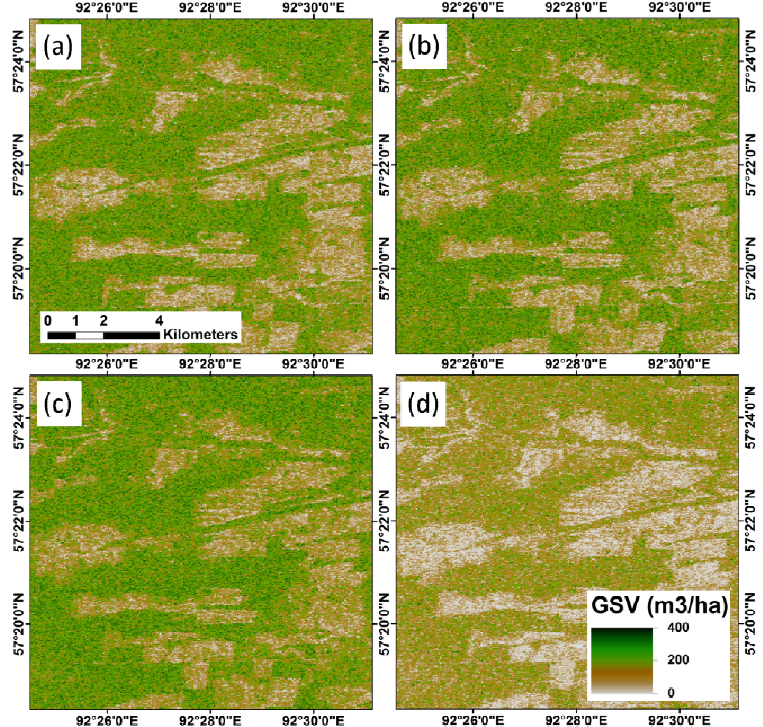
Figure 6. Detailed examples of the annual maps (southwestern area). ( a ) 2007; ( b ) 2008; ( c ) 2009; ( d )